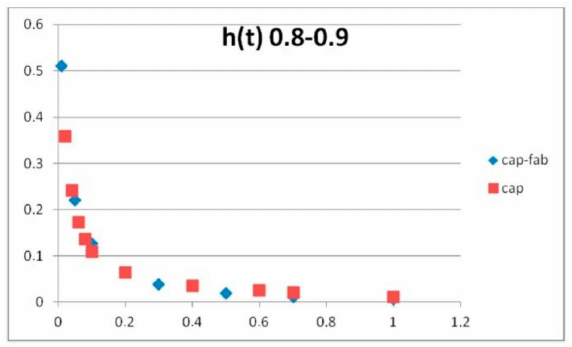
Figure 5. Comparison of the values of the kernels of the Caputo DOFD and the Caputo-Fabrizio DOFD when the order is distributed in the interval of integration